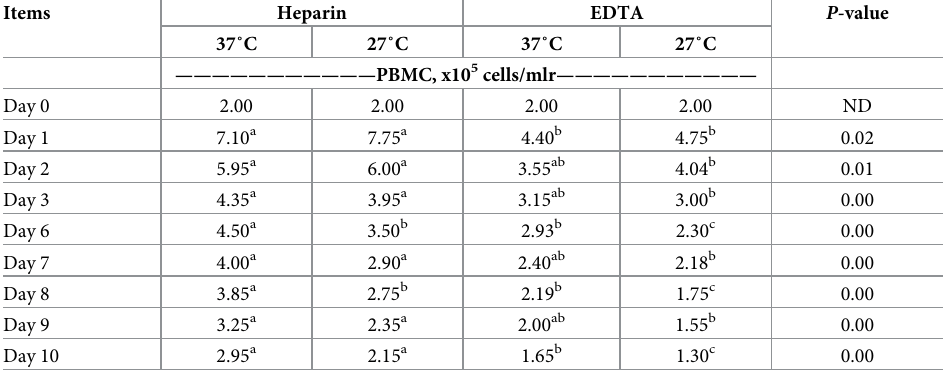
a,b,c Median values with different superscript letters within the same row were statistically significant (Friedman test, P < 0.05). ND = not determined.